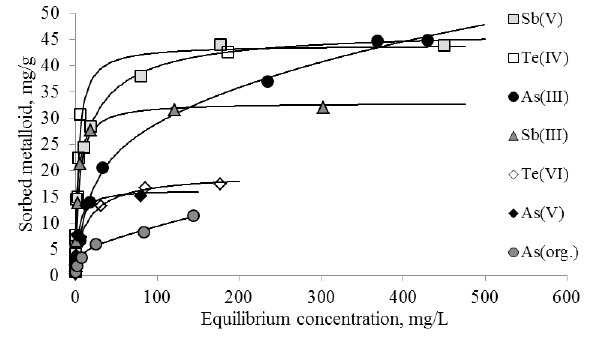
Figure 4: Removal of metalloids using Fe-modified peat (Gagu), sorption time 24 h at room